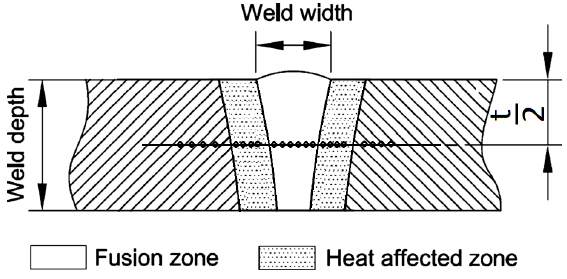
Figure 2. Scheme of microhardness testing.